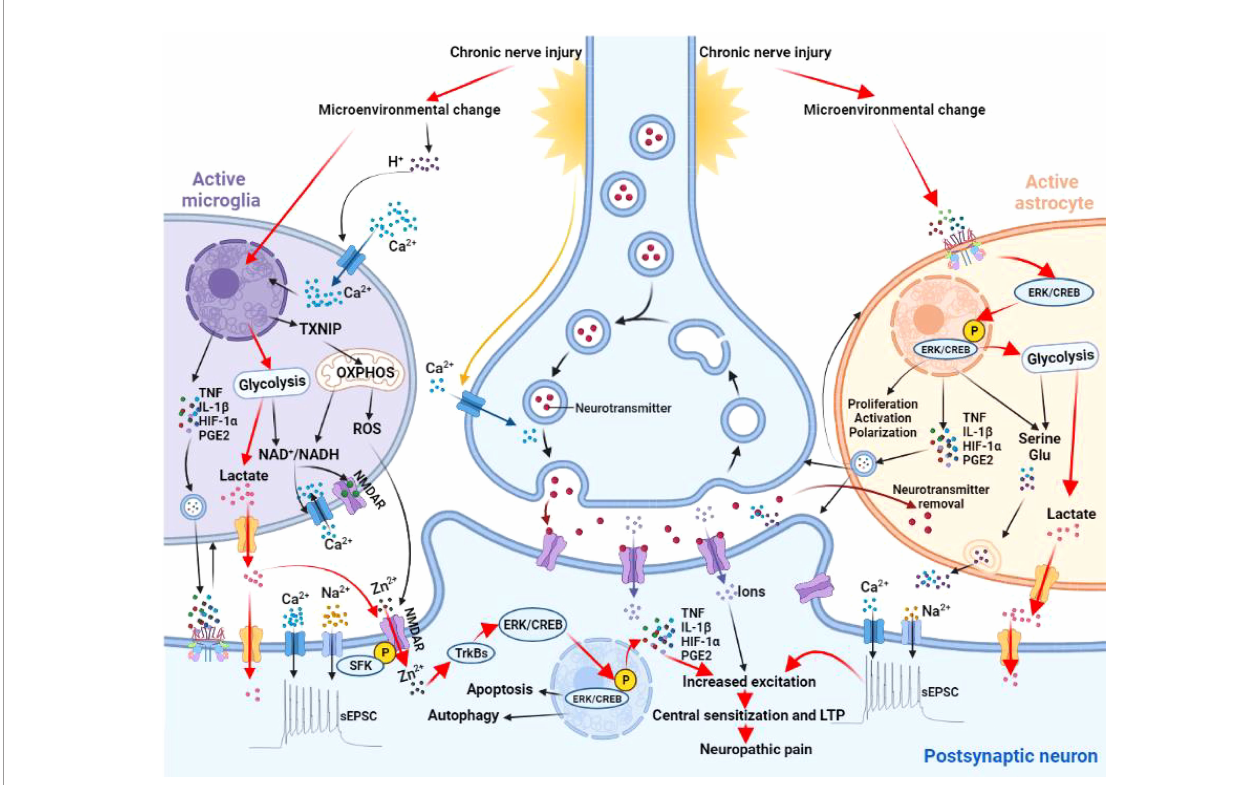
FIGURE 3 | Effects of microglia and astrocyte activation on synaptic plasticity. Microglia sense changes in synaptic microenvironment and H + accumulation activates a series of stress responses to shift microglia into activated state. These changes promote the transcription and expression of TXNIP, key enzymes of glycolysis and proin fl ammatory mediators (e.g.,TNF, IL-1 b , HIF-1 a , and PGE2). TXNIP is closely related to oxidative stress in producing ROS to increase cytomembrane permeability. Increased expression of key enzymes in glycolysis promotes lactate production and disrupts the balance of NAD + /NADH. An imbalanced NAD + /NADH ratio activates the NMDA receptor and increases Ca 2+ in fl ux to trigger downstream in fl ammatory cascade. Increased concentration of proin fl ammatory mediators in the vicinity of synapses promotes synaptic plasticity and polarization of microglia itself. Activation of NMDA receptors, Ca 2+ in fl ux and the downstream signaling cascade are regulated by SFKs and TrKB receptors. SFKs phosphorylates NMDA receptor subunits to promotes Zn 2+ entry into postsynaptic neurons through NMDA receptor channels to activate the TrKBs/ERK pathway. Phosphorylation of TrKBs/ERK promotes autophagy, apoptosis, and neuroin fl ammation. Astrocytes also sense the changes in synaptic microenvironment and activates the ERK/CREB signaling. Upon entering the nucleus, p -ERK activates p-CREB to initiate related gene transcription and promotes proliferation, activation, and polarization. Phosphorylation of ERK/ CREB also enhances glycolysis and proin fl ammatory mediators, leading to the accumulation of lactate, glutamate, and serine. All together, these changes increase the excitability of postsynaptic neurons and contribute to central sensitization in neuropathic pain. TXNIP, thioredoxin interacting protein; OXPHOS, oxidative phosphorylation; ROS, reactive oxygen species; NMDAR, N-methyl-D-aspartate receptor; HIF-1 a , hypoxia inducible factor-1 a ; TNF, tumor necrosis factor; IL-1 b , interleukin-1 b ; PGE2, prostaglandin E2; SFK, Src family kinases; ERK, extracellular signal regulated kinase; CREB, cyclic AMP response element binding protein; LTP, long-term potentiation; Glu, glutamate; sEPSC, spontaneous excitatory postsynaptic